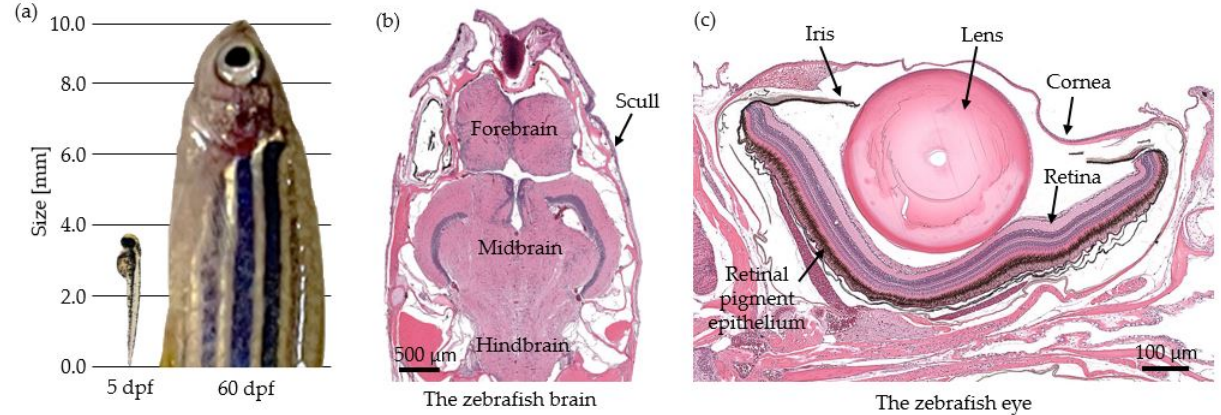
Figure 1. The size of the zebrafish and selected histology images. ( a ) Size comparison between 5 and 60 days post-fertilization (dpf). ( b ) Hematoxylin and Eosin (H&E)-stained transverse histology section of the zebrafish brain. (Link to the Bio-Atlas slide: http://bio-atlas.psu.edu/zf/view.php?s=193&atlas=16, accessed on 1 October 2022 [8]). ( c ) H&E-stained histology image of the zebrafish eye. (Link to the Bio-Atlas slide: http://bio-atlas.psu.edu/zf/view.php?s=182&atlas=16, accessed on 1 October 2022 [8]). Both histology images were retrieved from a one-year-old wildtype animal. Figure 2 gives an overview of various biomedical applications and research areas in which zebrafish models have been used. The development stage of the zebrafish needs to be chosen according to the investigated disease, organ and type of study [1,7].